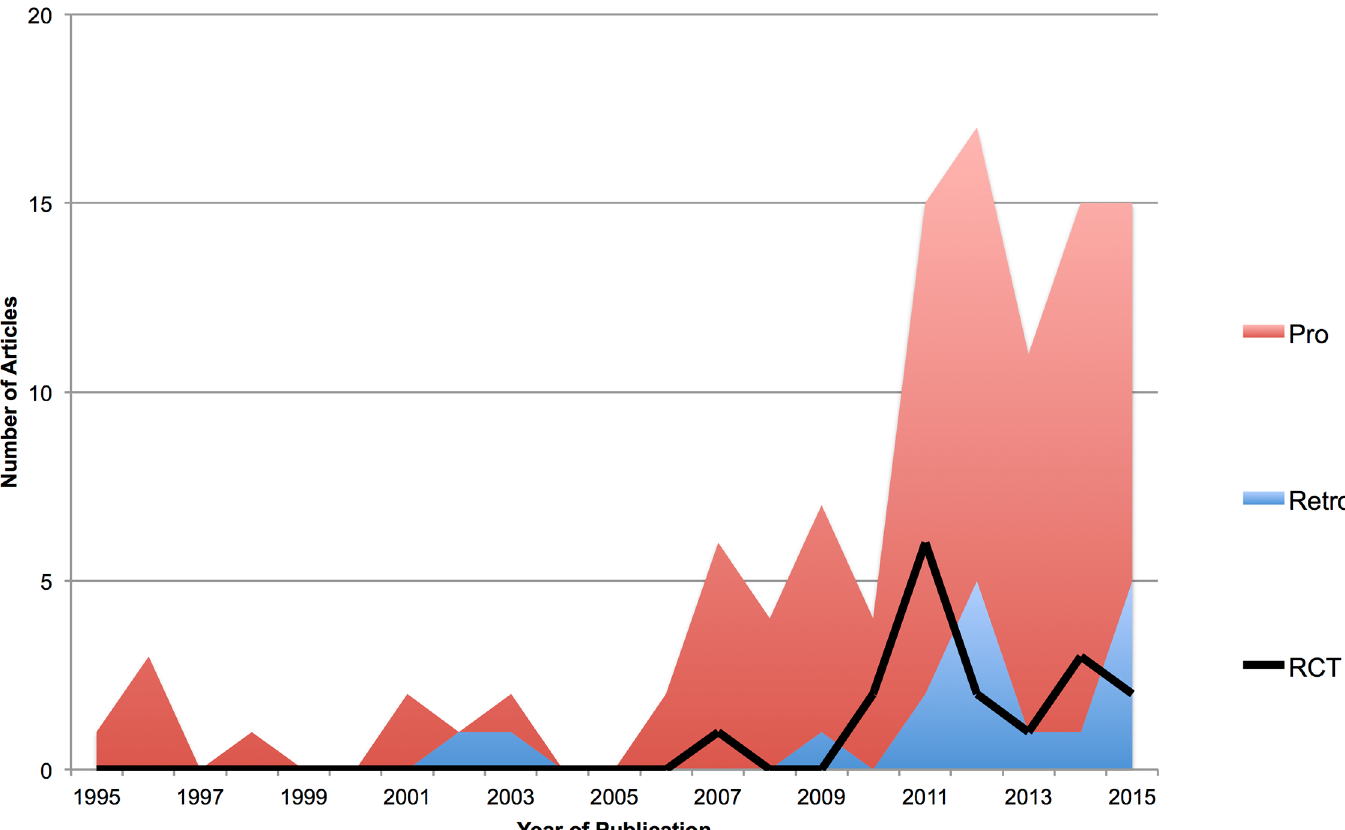
Fig 2. Trends in published research. Stacked line graph of year of publication of identified studies. Retrospective studies are in blue, prospective studies in red and the number of RCTs indicated by the black line. [Pro: Prospective, Retro: Retrospective, RCT: Randomised Controlled Trial]. The number of publications has increased over time, including those deemed of higher quality (prospective and